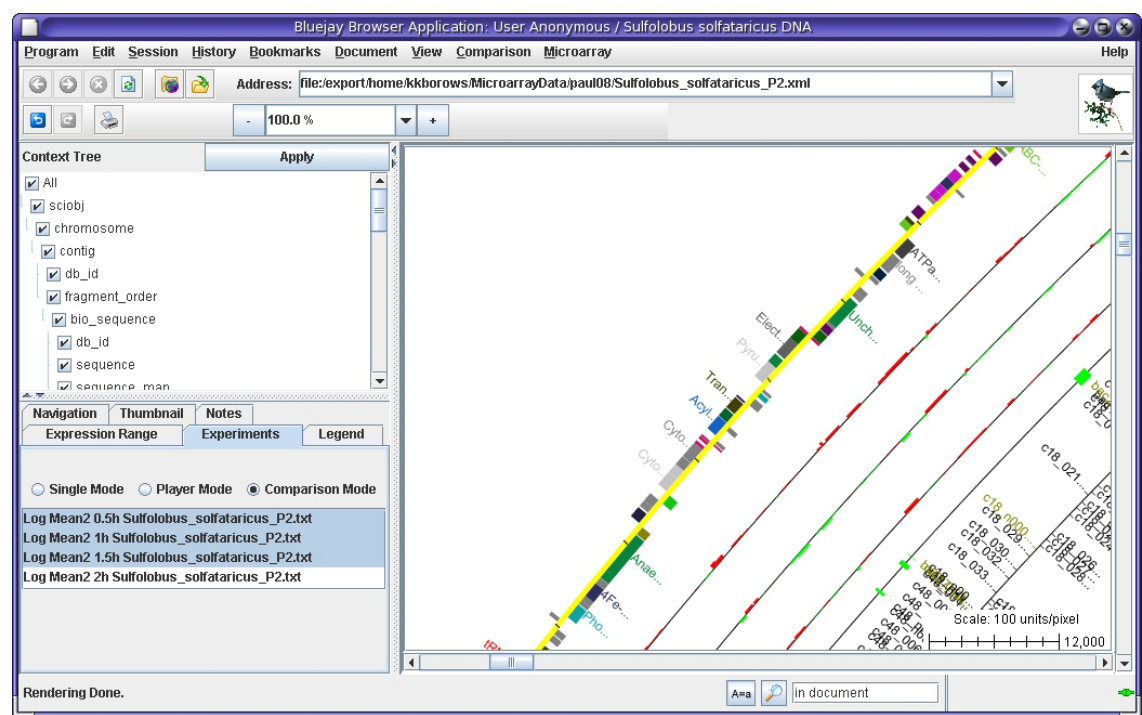
Figure 3: Sulfolobus solfataricus from Figure 2, with the same datasets selected. This is a zoomed- in view showing detailed expression comparisons, focused on a specific area of the